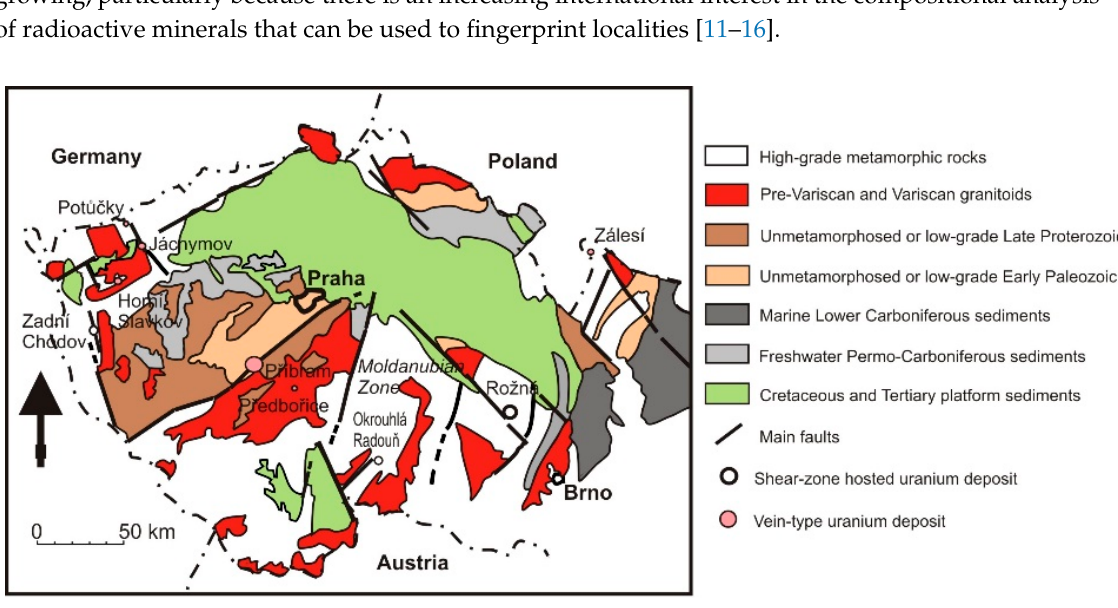
Figure 1. Simplified geological map of the Bohemian Massif showing the position of the most significant Czech basement-hosted uranium deposits.